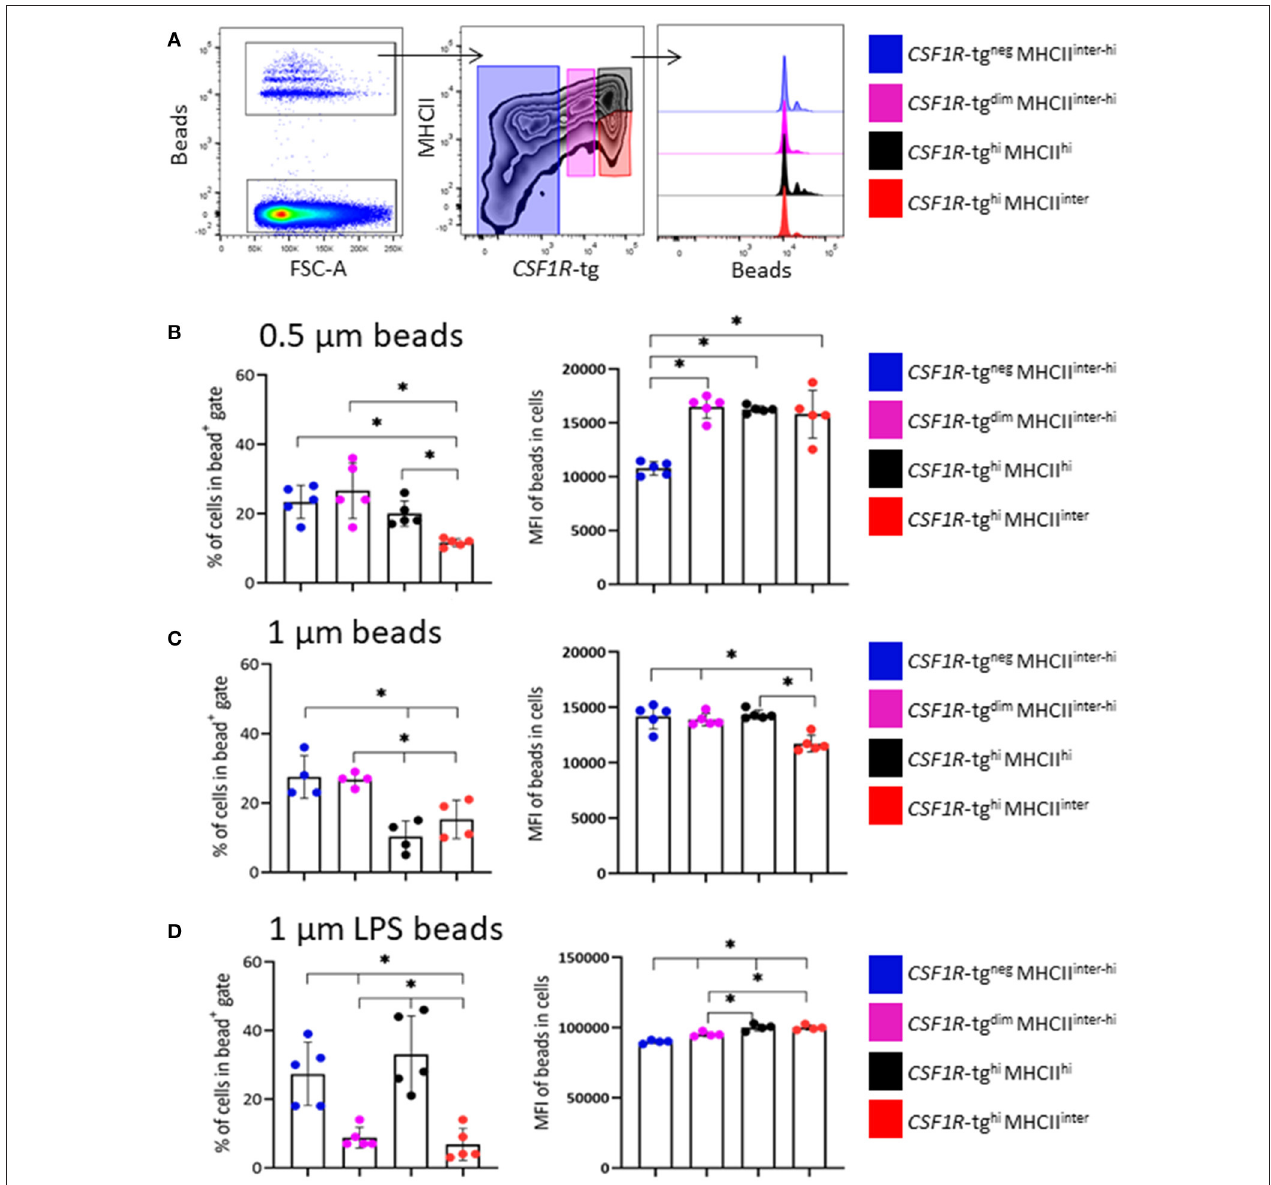
FIGURE 5 | The phagocytosis abilities of the CSF1R -tg hi MHCII inter cells is enhanced by LPS. (A) Representative flow plots and histograms of the gating strategy for the analysis of the cell phenotype based on CSF1R -tg and MHCII expression levels and phagocytosis of beads 3h post-IV bead administration by flow cytometry. The percentage of cells in each subpopulations within the bead + gate and MFI of the beads within each subpopulation; (B) 0.5 µ m; (C) 1 µ m and; (D) LPS labeled 1 µ m carboxylate fluorescent beads. Data is shown as the median of 5 or 4 individual chickens and error bars indicate 95% confidence intervals. Asterisks indicate statistical significance ( P <